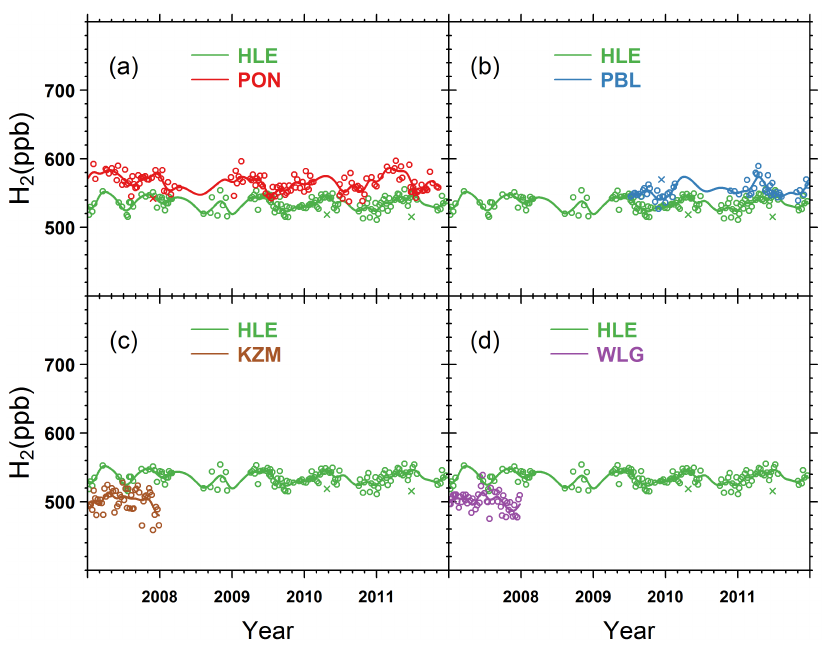
Figure 12. Time series of H 2 flask measurements at (a) HLE and PON, (b) HLE and PBL, (c) HLE and KZM, and (d) HLE and WLG. The open circles denote flask data used to fit the smoothed curves, while the crosses denote discarded flask data lying outside 3 times the residual standard deviations from the smoothed curve fits. For each station, the smoothed curve is fitted using Thoning’s method (Thoning et al., 1989) after removing